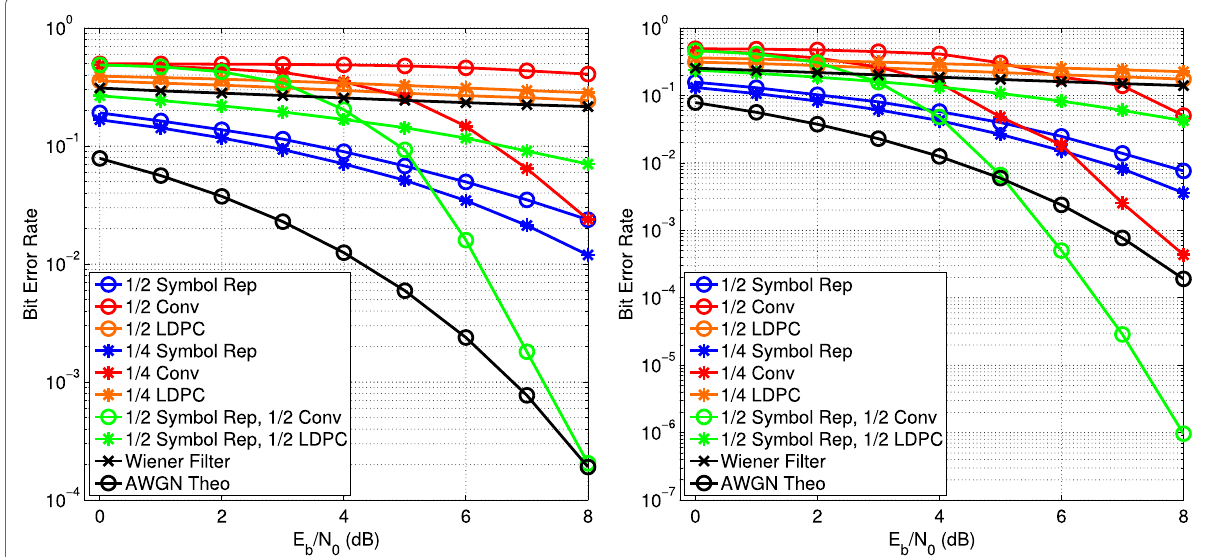
Fig. 8 The BER curves comparing the performance of the 1/2 Rate Symbol Repetition PFD (blue circle), 1/4 Rate Symbol Repetition PFD (blue star), 1/2 Rate Convolutional Code (red circle), 1/4 Rate Convolutional Code (red star), 1/2 Rate LDPC (orange circle), 1/4 Rate LDPC (orange star), combined 1/2 Rate Symbol Repetition and 1/2 Rate Convolutional Code (green circle), combined 1/2 Rate Symbol Repetition and 1/2 Rate LDPC (green star), Wiener Filter (black x). The AWGN Theoretical is plotted with a black circle. All BER curves are plotted as a function of E b / N 0 . a Bandwidth overlap of 1/2. b Bandwidth overlap of